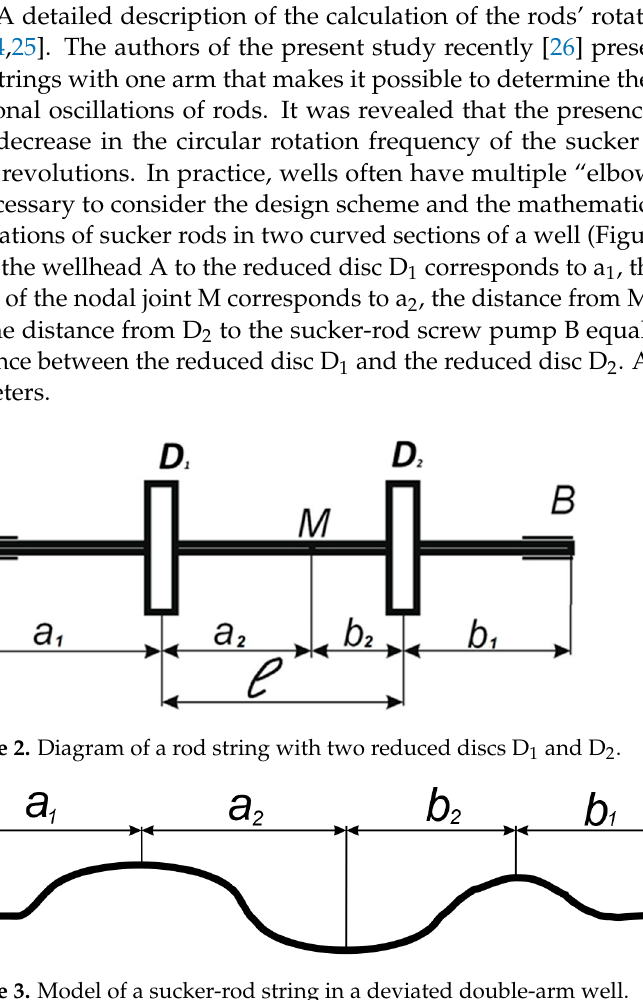
Figure 3. Model of a sucker-rod string in a deviated double-arm well.